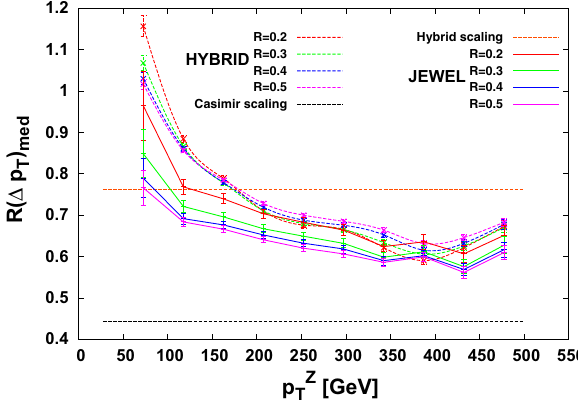
Fig. 6 R (Δ p T ) med asafunctionoftheinitialparton p T forthesamples with ISR. The Hybrid model samples are shown with spline lines are correspond to a 0–10% centrality